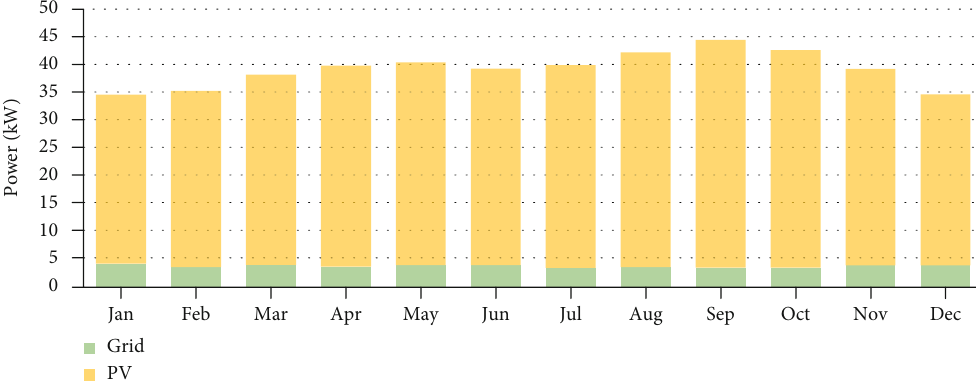
Figure 8: Monthly average electricity